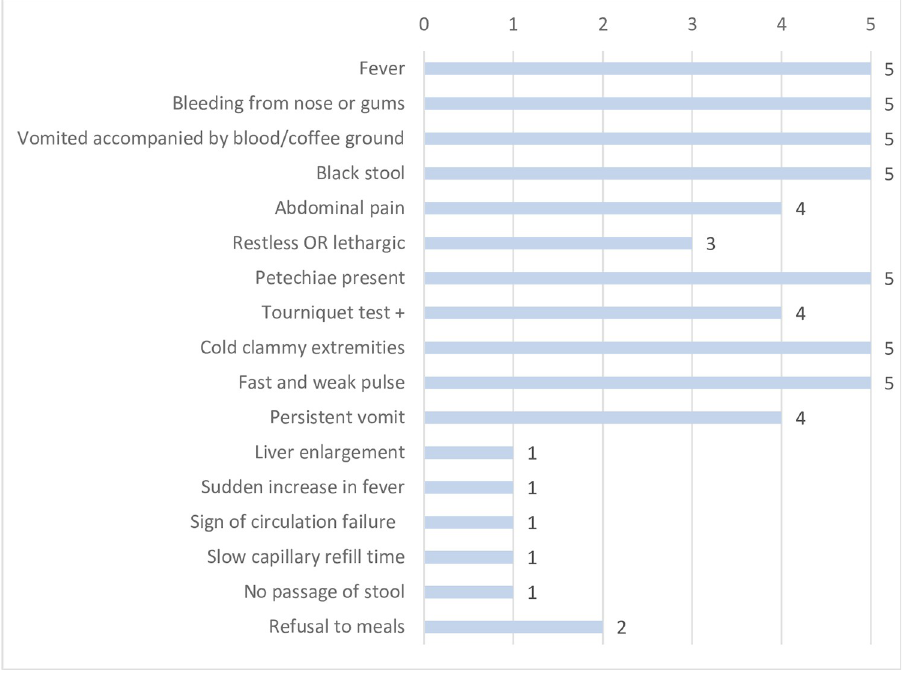
Fig 1. Frequency of signs and symptoms for assessment of dengue in five Southeast Asian Integrated Management of Childhood Illness (IMCI) adaptations (for children 2 month to 5 years of age).